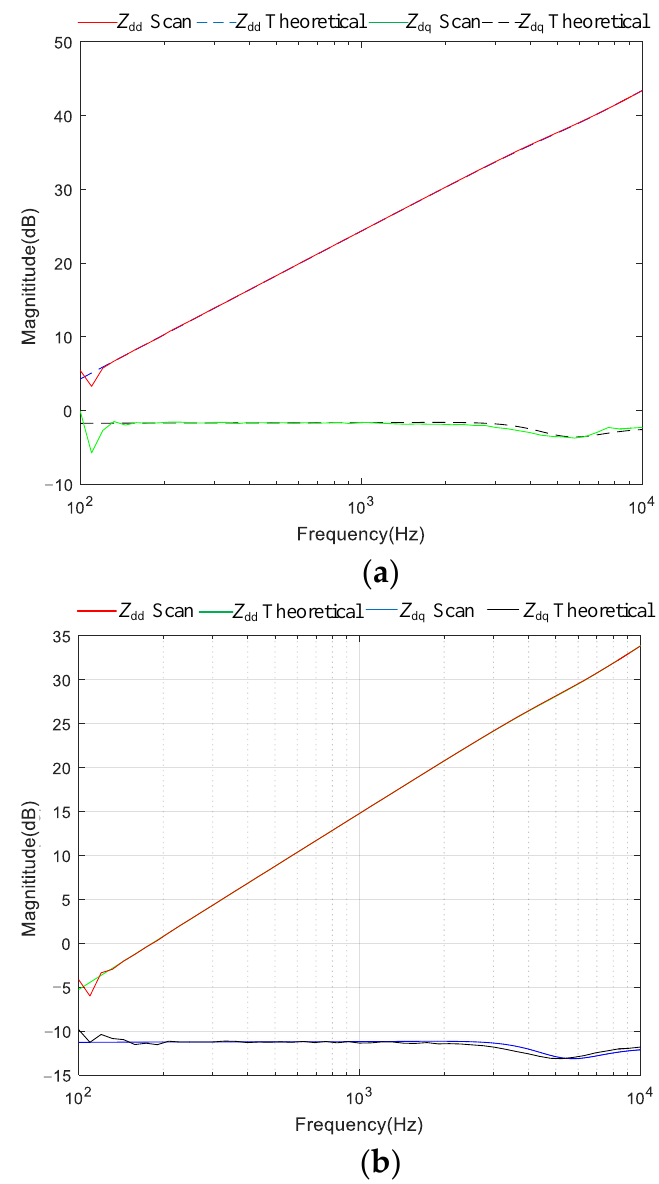
Figure 15. Comparison results of the output impedance in theory and calculation. ( a ) Comparison results of the output impedance of a single VSG. ( b ) Comparison results of the output impedance of three VSGs.